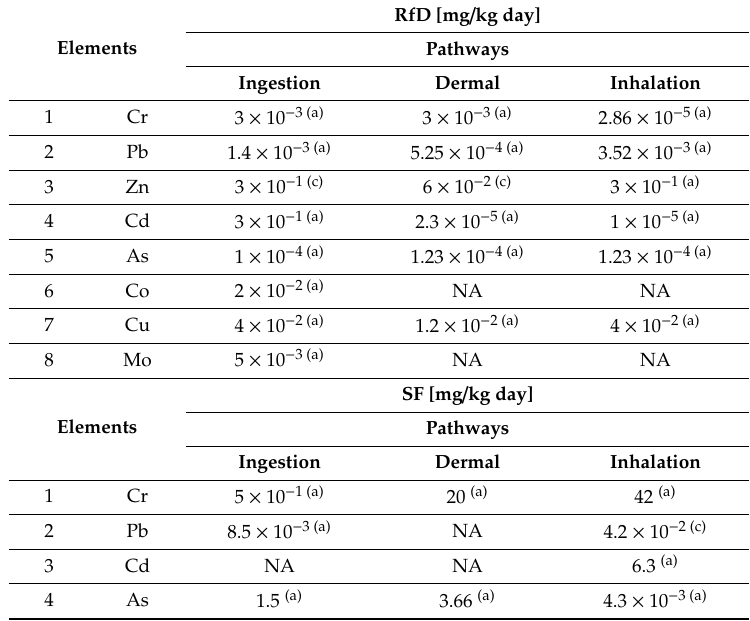
Table 3. RfD (reference dose) and SF (slope factor) [mg / kg day] values used in the present